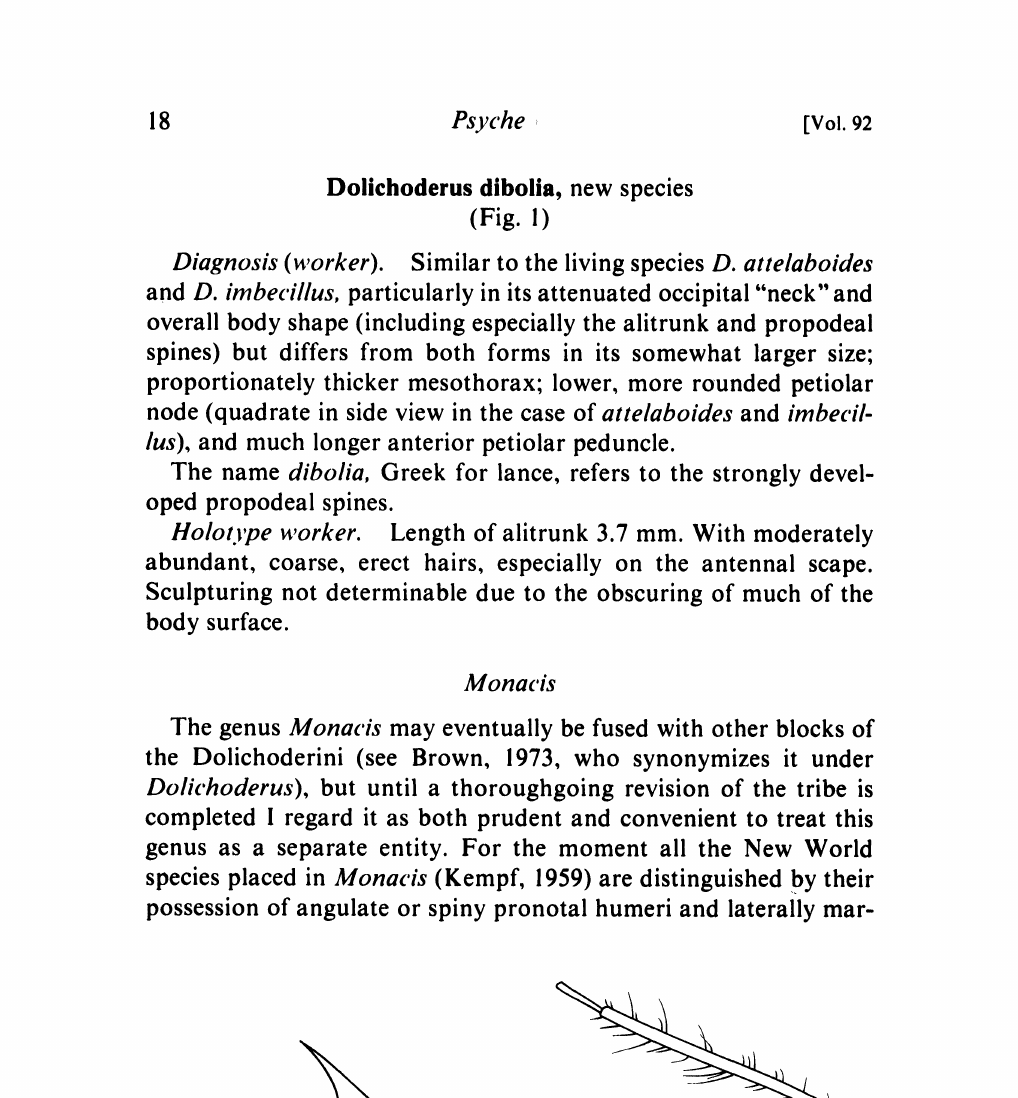
Fig. I. Dofichoderus diholia worker holotype, side view of